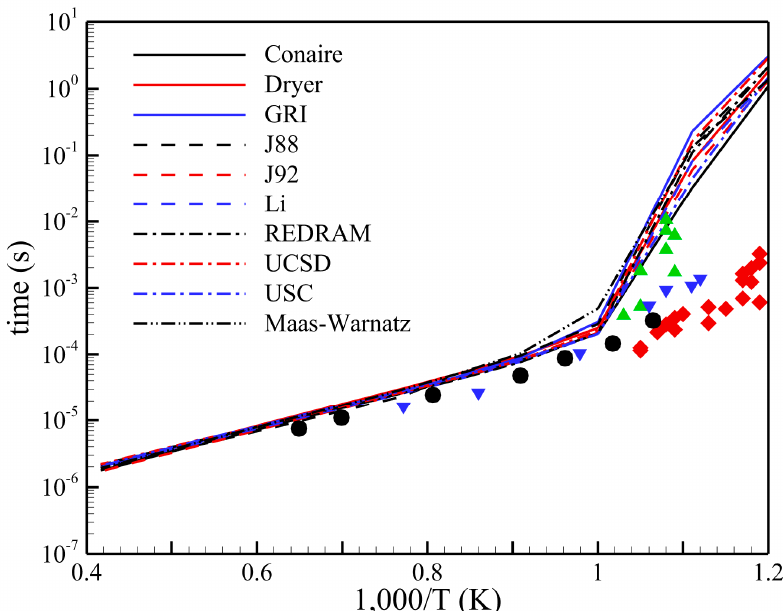
Figure 3. Ignition delays calculated at 1 bar (symbol represents the experimental results from ReSpecTh repository).